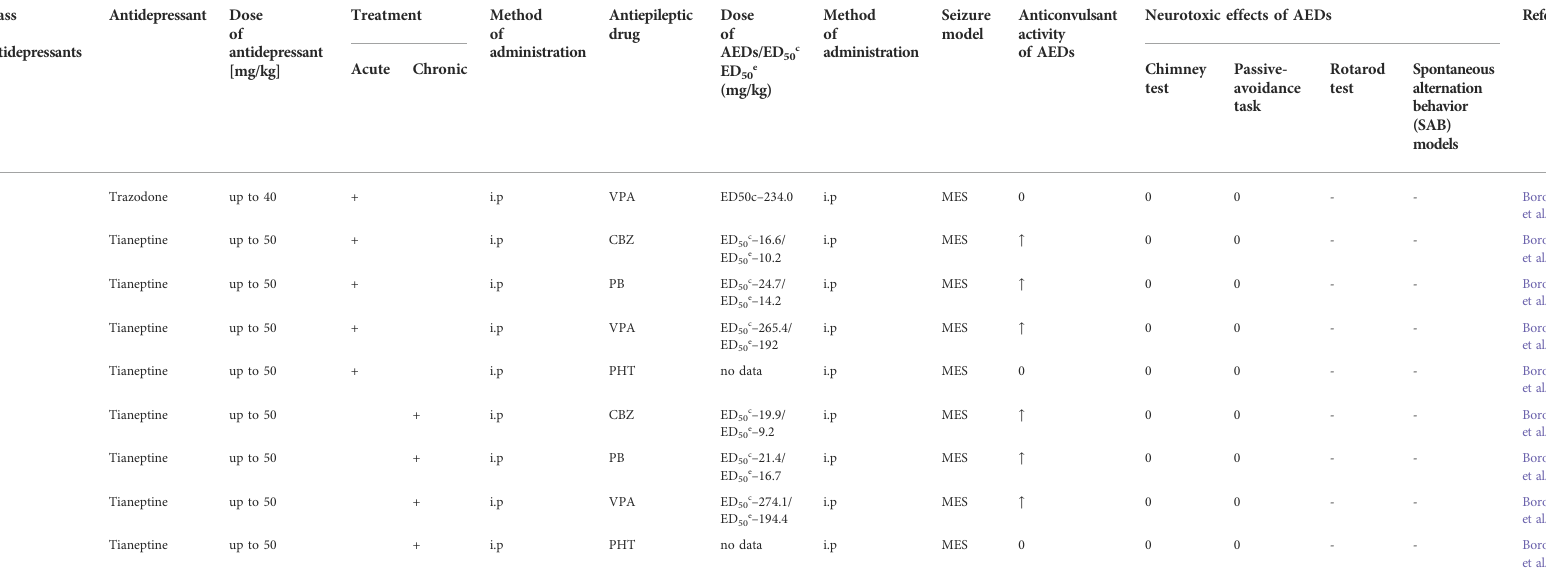
TABLE 2 ( Continued ) Interactions between AEDs and antidepressant drugs in experimental seizure